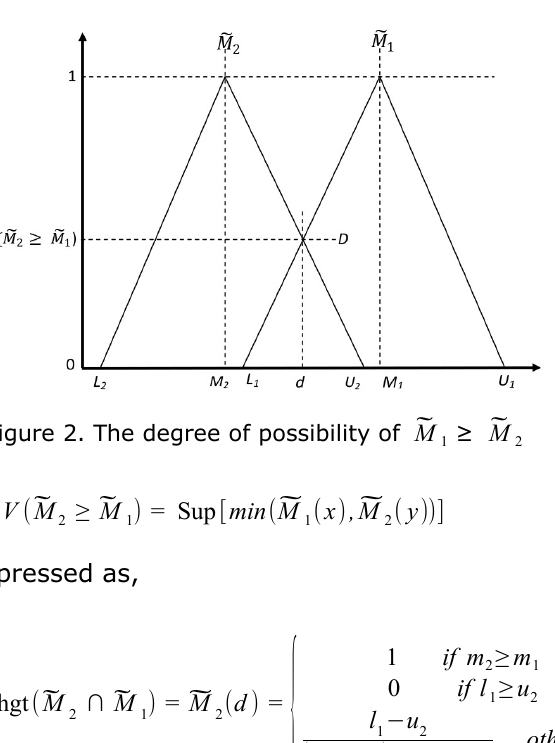
Figure 2. The degree of possibility of ̃ M